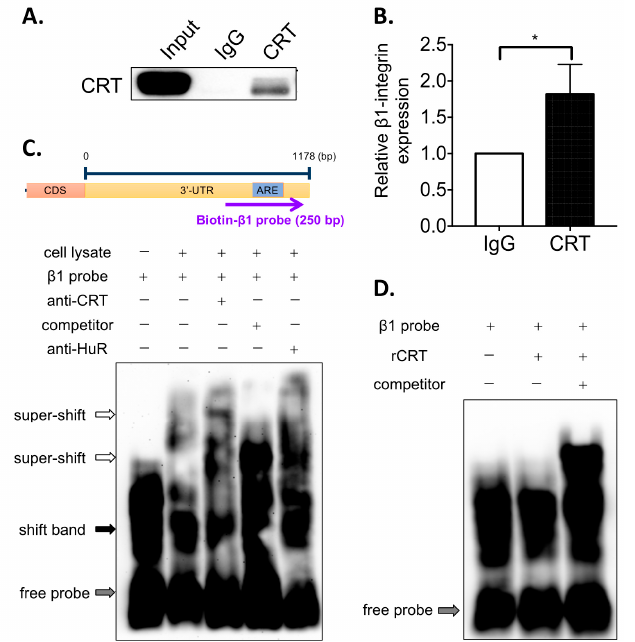
Figure 3. CRT interacts with β 1-integrin mRNA through ARE. RNA-IP analysis of the interactions of CRT and mRNA of β 1-integrin in the total cell lysate of PC-3 cells. The total cell lysates were mixed with anti-CRT antibody or anti-IgG to pull-down CRT and CRT-associated RNA. Protein-associated RNA was pulled down by magnetic protein A/G beads. ( A ) The levels of protein expressions are analyzed by Western blot. ( B ) β 1 integrin RNA pulled down by anti-CRT and anti-IgG antibodies were extracted and further analyzed by real-time PCR. ( C , D ) RNA electrophoretic mobility shift assay (EMSA) was performed. The cell lysate was mixed with biotin-labeled ARE probes of β 1-integrin and further incubated with unlabeled competitor probes or anti-CRT and anti-HuR antibodies. ( D ) Recombinant protein of CRT (rCRT, 240 ng) was mixed with biotin-labeled ARE probes of β 1- integrin and further incubated with unlabeled competitor probes. Results are shown as mean ± SD. All the experiments were repeated at least three times. * p <